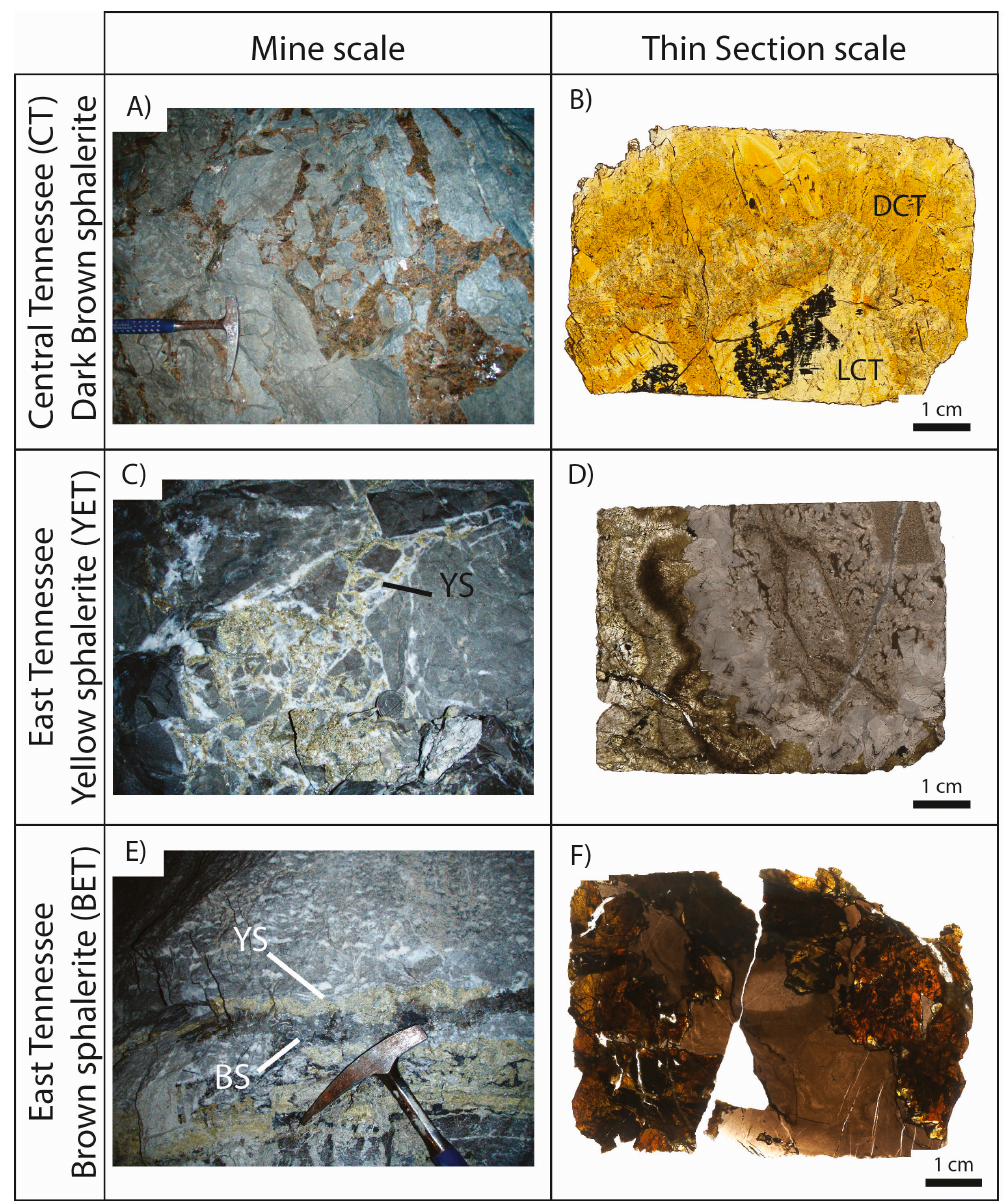
Figure 2. Sphalerite samples from Tennessee mines (YS: Yellow sphalerite; BS: Brown sphalerite). ( A ) Reddish-brown sphalerite from Central Tennessee; ( B ) Polished section of sphalerite from CT with dark (DCT) and light (LCT) banding; ( C ) Yellow sphalerite from East Tennessee (YET); ( D ) Polished section of Yellow sphalerite from ET; ( E ) Brown sphalerite (BET) with yellow sphalerite from East Tennessee; ( F ) Polished section of brown sphalerite from ET.